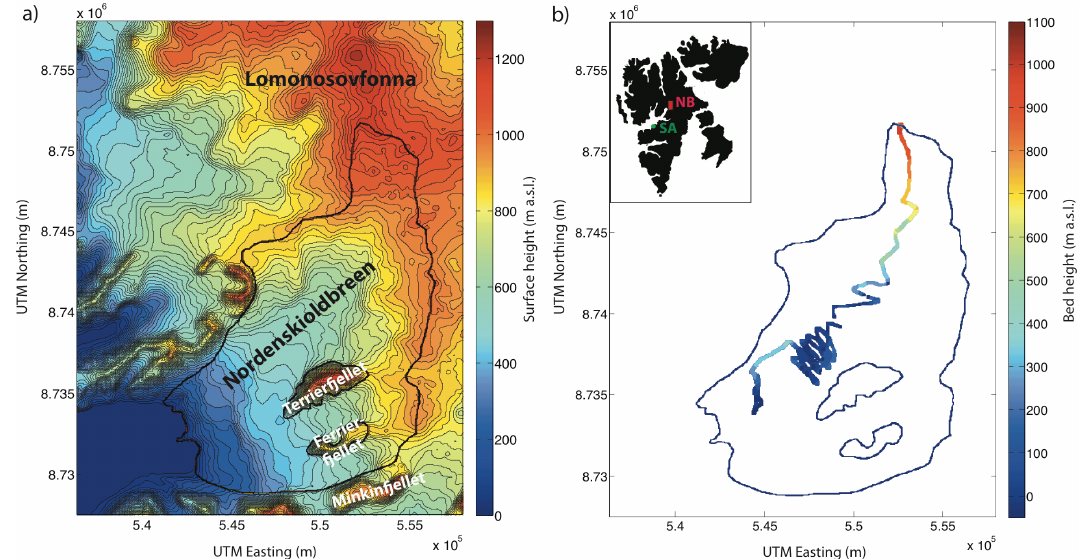
Fig. 6. Observed surface heights from a DEM (a) and bed heights from radio-echo sounding (b) . The black line marks the extent of Norden- ski¨oldbreen, connected along the ice divide to the Lomonosovfonna ice plateau. The location of mountain ridges Terrierfjellet, Ferrierfjellet and Minkinfjellet is indicated. The inset figure in (b) shows the Svalbard archipelago with the position of Svalbard Airport (SA) and Nor- denski¨oldbreen